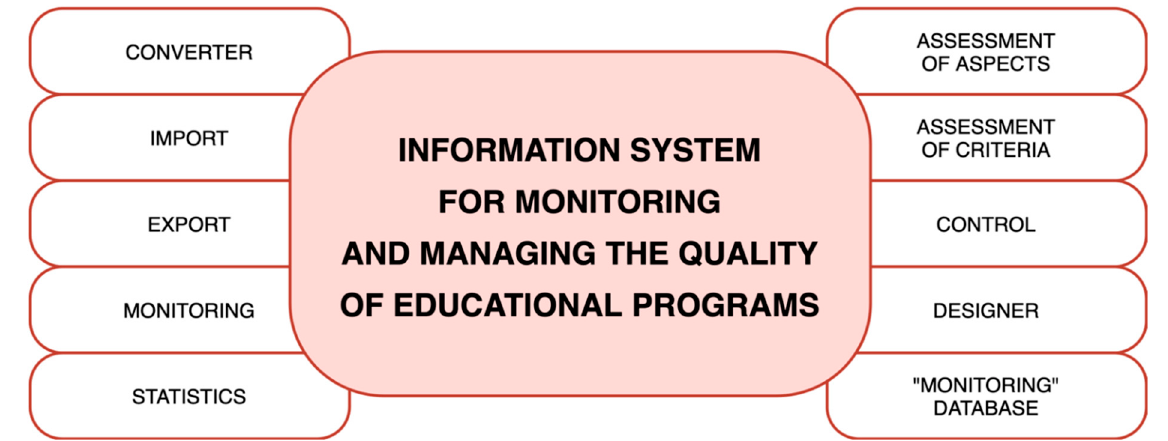
Figure 3. The structure of an information system for monitoring and managing the quality of educational programs.